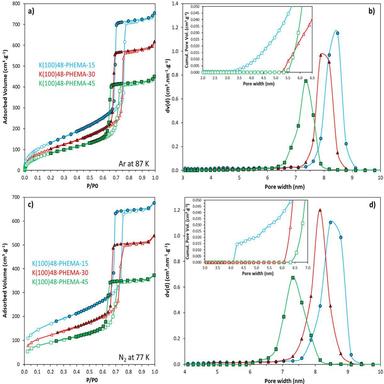
Ar at 186 C and N2 at 196 C physisorption isotherms (a, c) and corresponding NLDFT desorption pore size distributions (b, d) of K(100)48-PHEMA composite materials. Magnified NLDFT cumulative pore volume curves, calculated from the adsorption branches, are presented in insets.